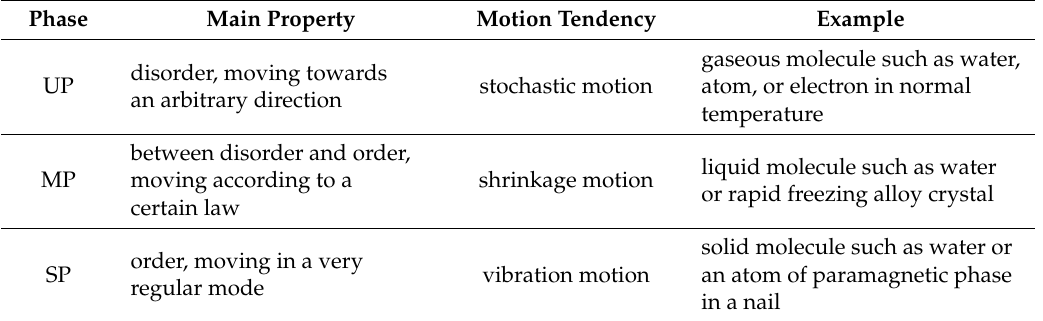
Table 1. The motional characteristics of elements in the three phases.